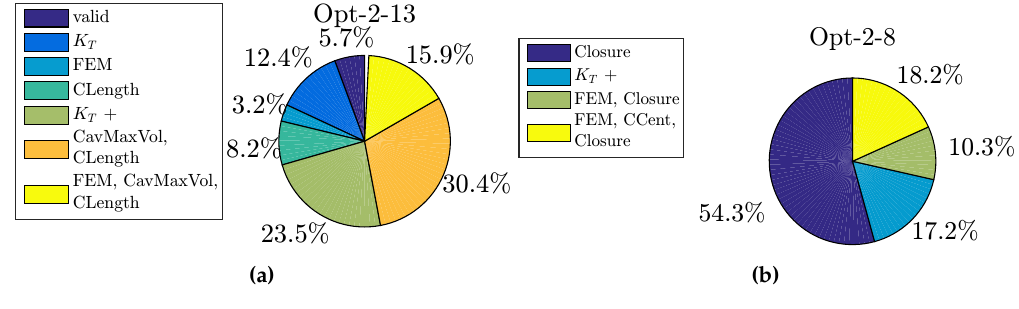
Figure 9. Analysis of constraint violation considering all created variant per optimisation case. ( a ) Opt-2-13; ( b ) Opt-2-8.